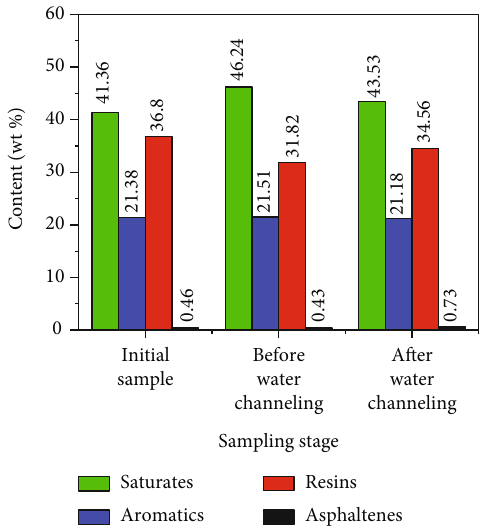
Figure 5: Comparison of four components of crude oil produced during steam fl ooding.